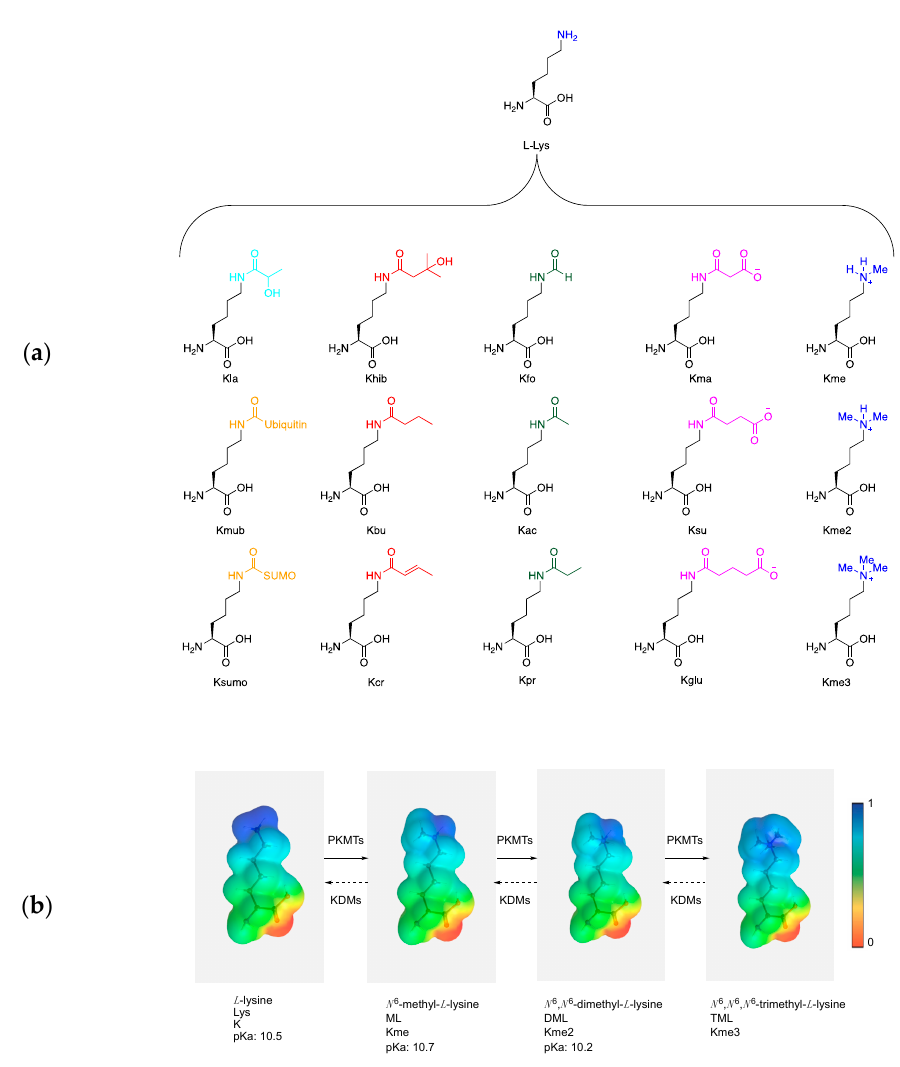
Figure 1. Chemical properties of L-lysine and modified lysine residues [1,8,30]. ( a ) Schematic overview of naturally occurring post-translational modifications (PTMs) of L-lysine. ( b ) Electrostatic potential surface of L-lysine and its methylated analogues. Images created with WebMO software, www.webmo.net [30].